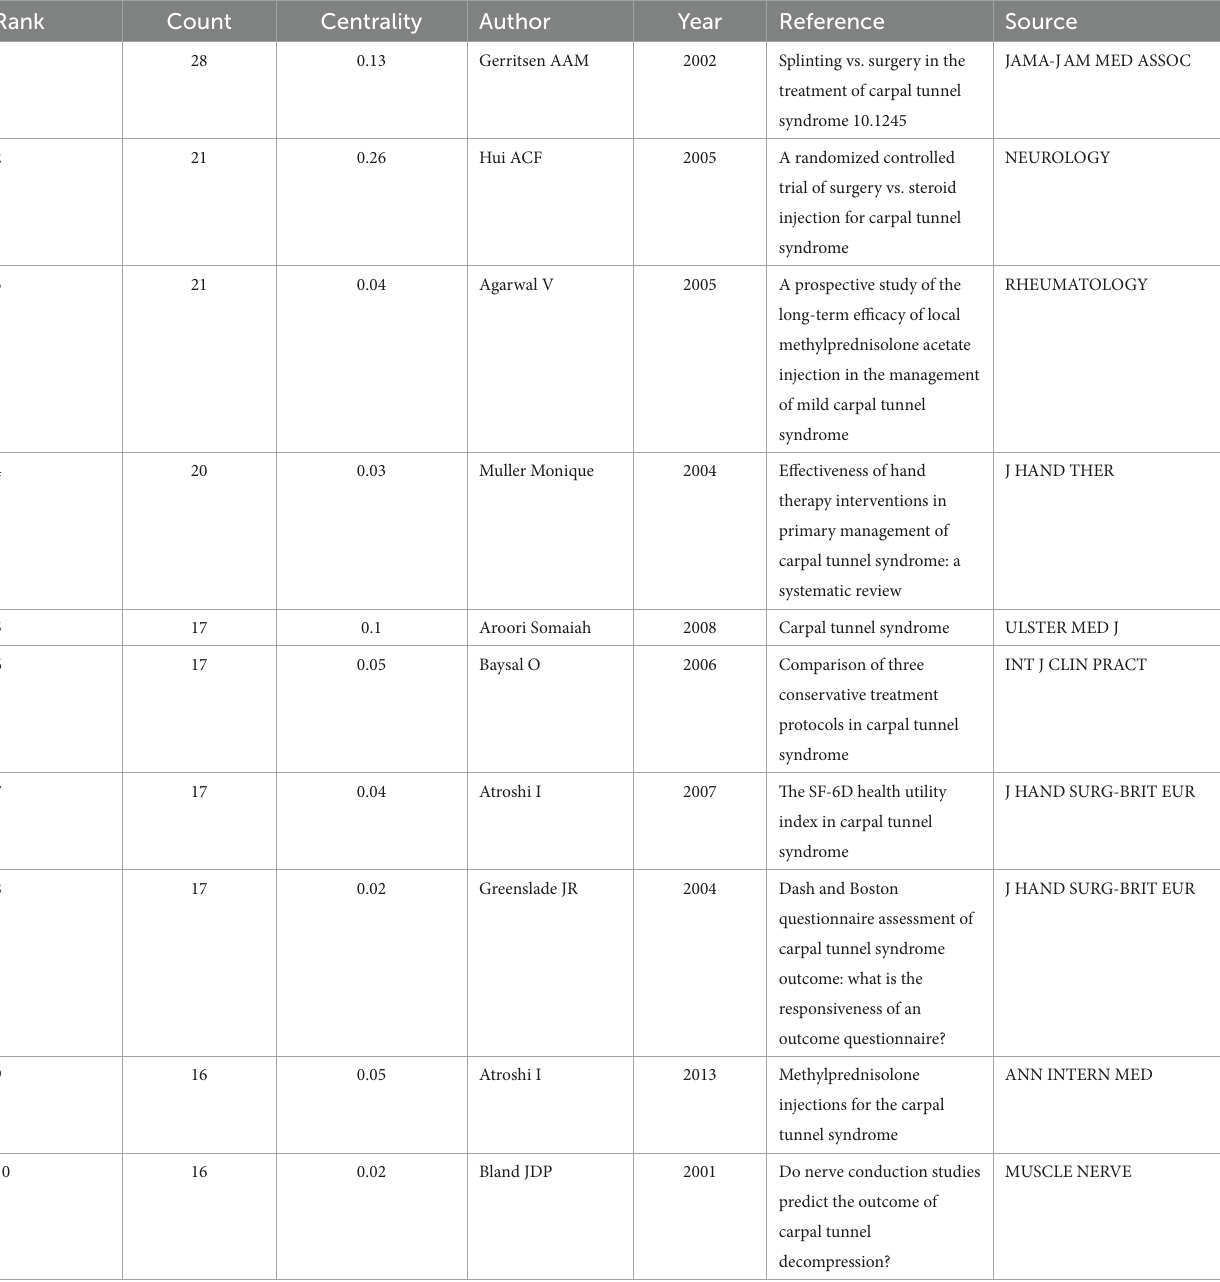
TABLE 4 Top-10 most frequently cited articles in the field of surgical treatment of CTS research in total. Rank Count